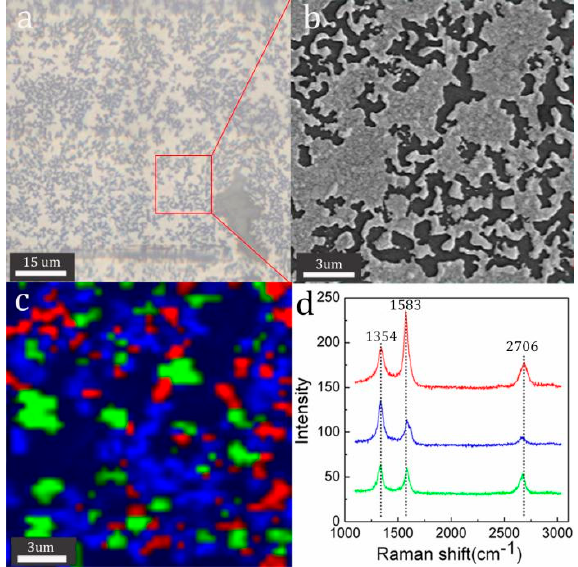
Figure 2. ( a ) Optical microscope image of the quenched Si wafer; the inserted image in Figure 2a is the corresponding selected area of SEM-Raman; ( b , c ) the SEM-Raman images (( b ) is the corresponding SEM image and c is the corresponding Raman mapping); ( d ) three typical Raman spectra with different colours from the areas with corresponding colours in ( c ).